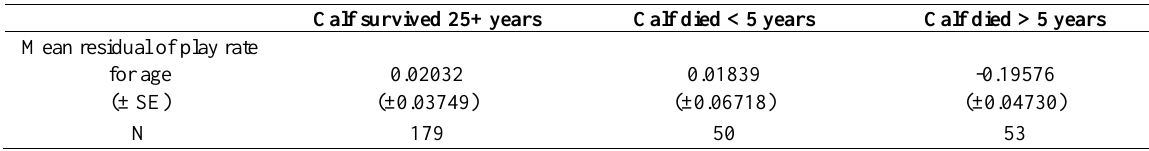
Age-specific Play Rates for Calves that Survived for 25+ Years, Calves that Died Before Completed Weaning, and Calves that Died After Weaning Calf survived 25+ years Calf died < 5 years Calf died > 5 years Mean residual of play rate for